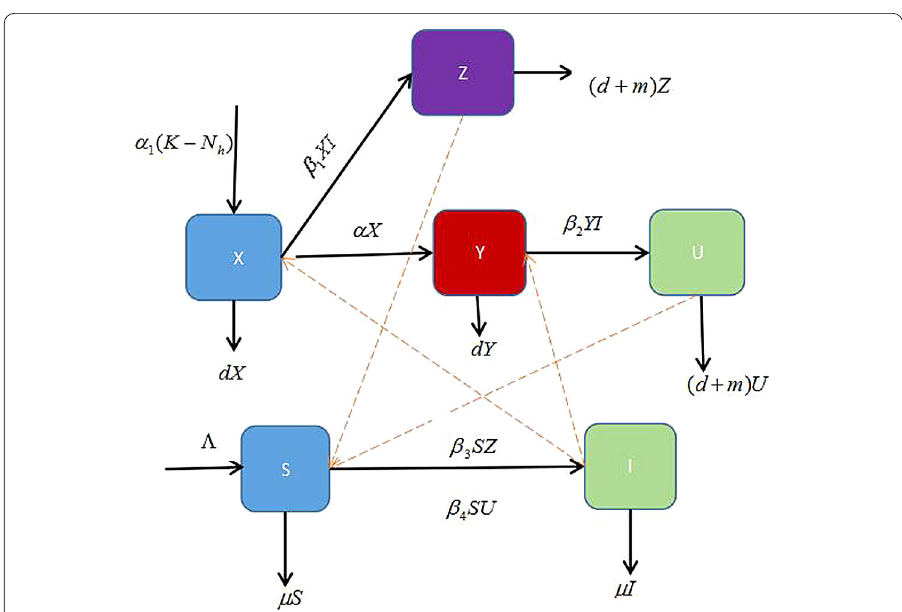
Figure 1 A schematic of the model system showing transitions to different categories for trees and psyllids. Black arrows show the transitions between compartments. Orange dashed arrows show the necessary interactions between trees and psyllids to obtain